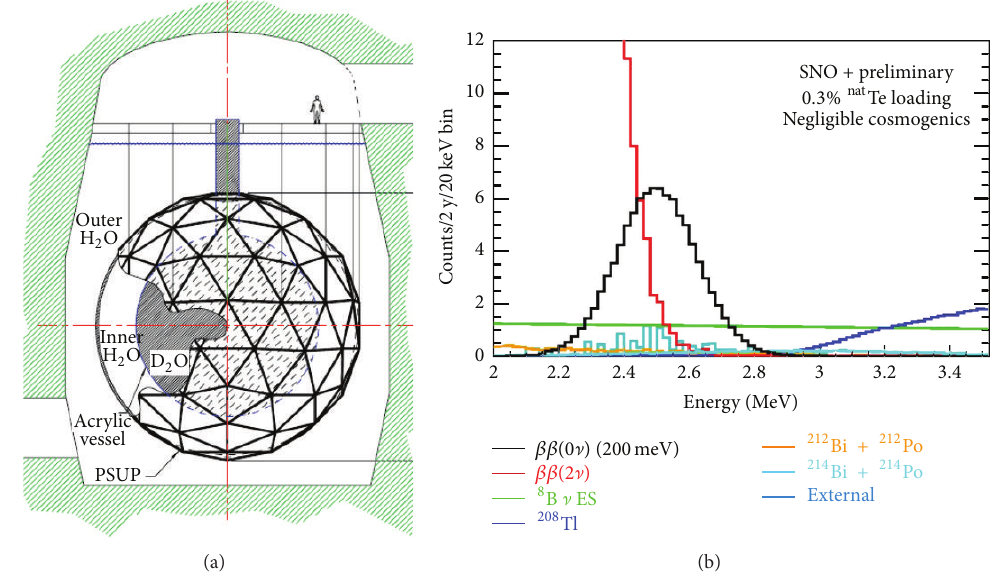
Figure 15: (a) SNO detector (figure from [168]). (b) background prediction (figure from